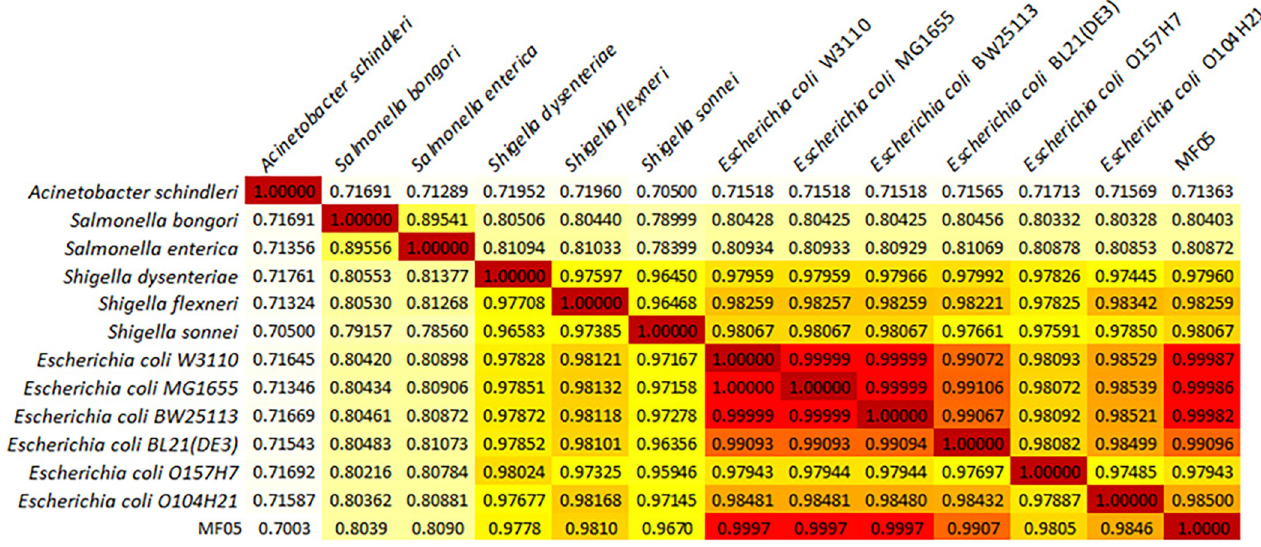
Fig 1. Heatmap of ANI analysis for MF05 against 12 different proteobacteria strains. Nucleotide identity comparison between Acinetobacter schindleri ACE, Salmonella bongori NCTC 12419, S . enterica serovar Typhi CT18, Shigella sonnei BS1058, S . dysenteriae Sd197, S . flexneri 301, E . coli BW25113, E . coli MG1655, E . coli W3110, E . coli BL21 (DE3), E . coli O157:H7 Sakai, E . coli O104:H21 CSFSAN00236 and MF05.